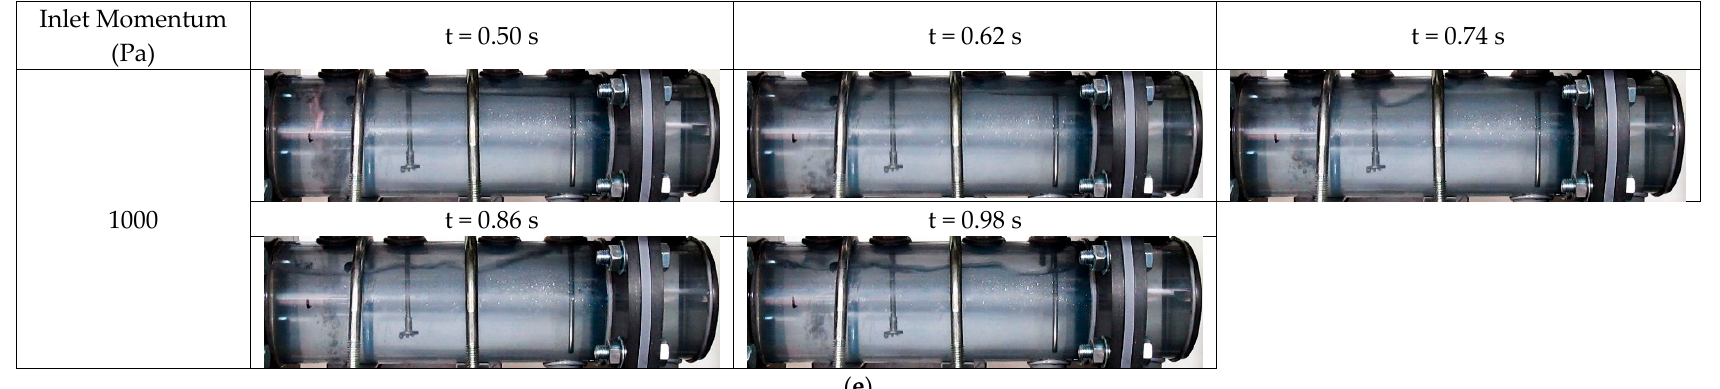
Figure 5. ( a ) Experimental observations for hydrodynamics inside the separator for 200 Pa; ( b ) Experiment observations for hydrodynamics inside the separator for 400 Pa; ( c ) Experimental observations for hydrodynamics inside the separator for 600 Pa; ( d ) Experiment observations for hydrodynamics inside the separator for 800 Pa; ( e ) Experiment observations for hydrodynamics inside the separator for 1000 Pa.